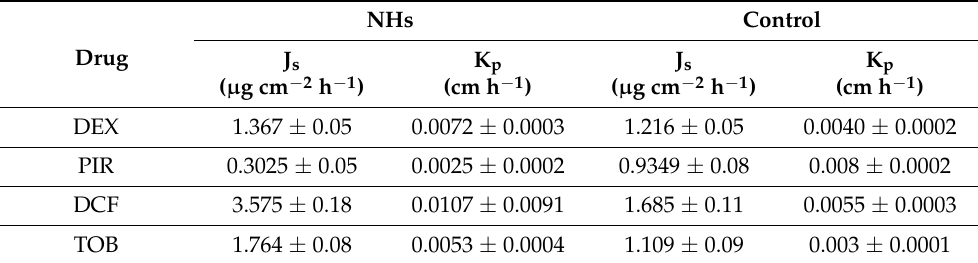
Table 1. Flux (J S ) and permeability coefficient (K P ) values, calculated from the porcine cornea permeation experiments, for DEX, PIR, DCF and TOB as free drug solution/suspension or drug- loaded NHs.